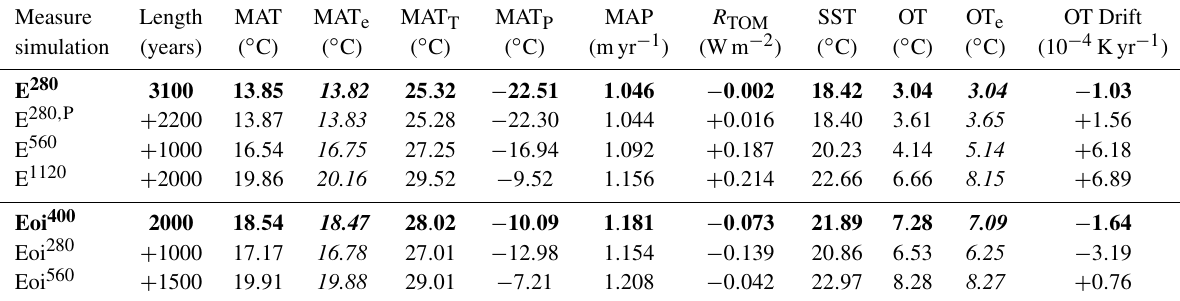
Table 1. Overview of globally averaged observables and equilibration measures for all of our simulated cases, including simulation length ( + denotes a continuation from the above control case), mean annual 2m air temperature (MAT), average tropical temperature (MAT T ), average polar temperature (MAT P ), mean annual precipitation (MAP), top-of-model net radiative flux ( R TOM ), sea surface temperature (SST), full-depth ocean temperature (OT), and ocean temperature drift. Subscript “e” denotes estimated equilibration values. Measure Length MAT MAT e MAT T MAT P MAP R TOM simulation